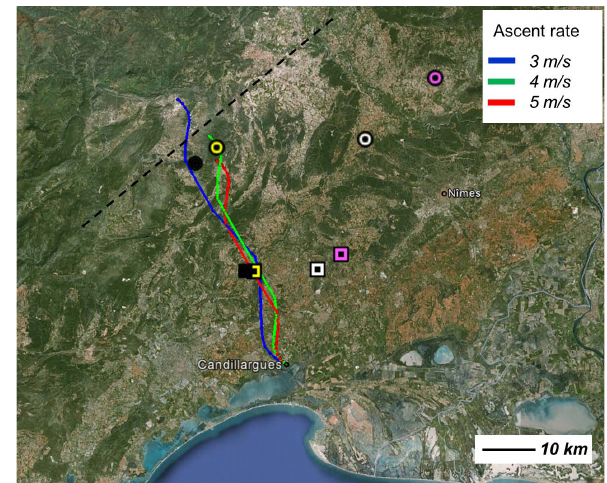
Fig. 5. Flight trajectory simulations valid 21 October 2012 at 15:00UTC, according to the wind profile and sounding settings displayed in Fig. 3. The launch site is located in Candillargues, along the Mediterranean coast. Blue, green and red trajectories correspond to flight simulations made from mean ascent rates of 3, 4 and 5ms − 1 , respectively. The yellow circle (square) indi- cates the actual landing point (separation point) of the radiosonde. Other circles/squares show the actual landing (separation point) of soundings performed at 10:50UTC, 21 October 2012 (black), 09:03UTC, 17 October 2012 (white) and 11:55UTC, 17 Octo- ber 2012 (pink).The foothills of the Massif Central mountains are indicated by the dashed black